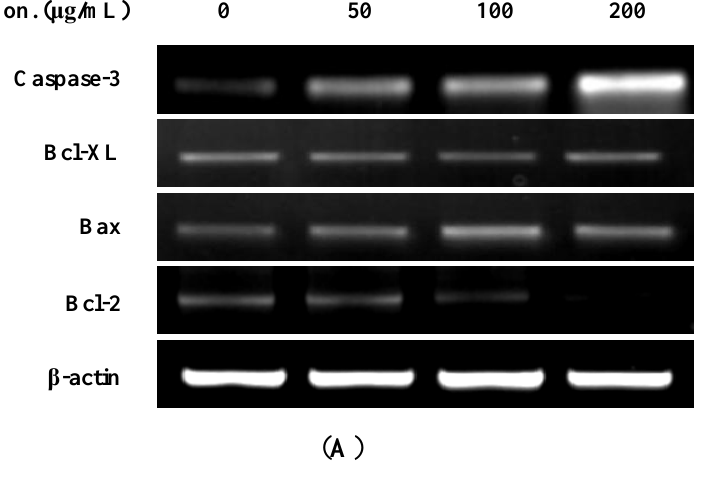
Figure 4. ( A ) RT-PCR anlysis for Bcl-2, Bax, Bcl-XL, and caspase-3 mRNA expression on L. echinata extract-stimulated HT-29 cells. Cells were plated in 6-well plates and incubated with L. echinata for 24 h; ( B ) The ratio of Bax to Bcl-2 was determined by densitometric